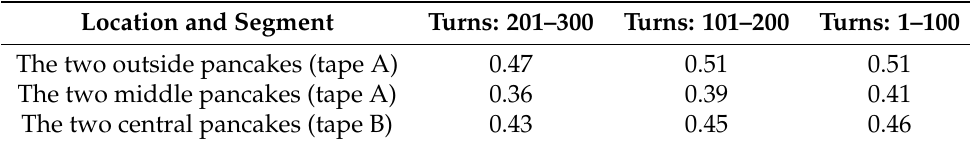
Table 2. Maximum load factors on different locations and segments of a single pole.